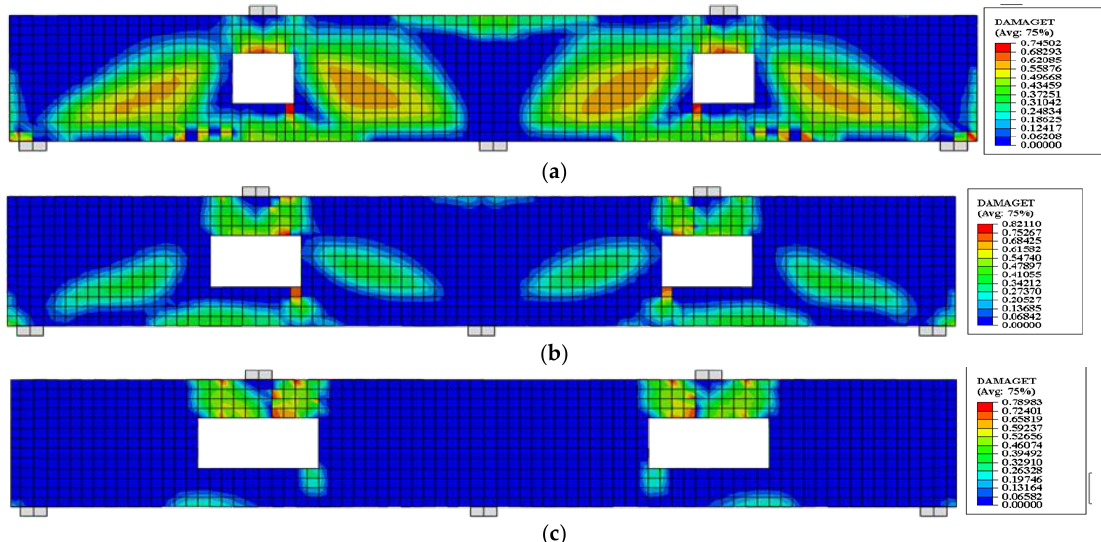
Figure 15. Effect of ratios of the opening dimensions on the FE crack patterns for the un-strengthened RCCDBs. ( a ) CDB – O – U-R1.0; ( b ) CDB – O – U-R1.5; ( c ) CDB – O – U-R2.0.